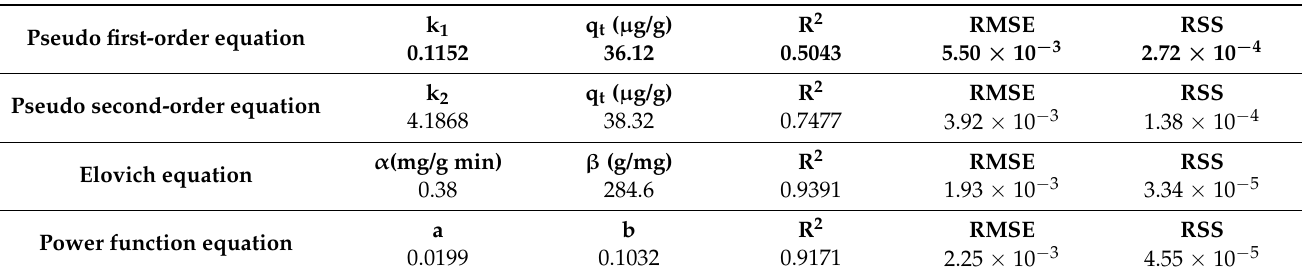
Figure 7. Adsorption kinetics study with several models for As(V) (Conditions: pH = 5, dose 2 g/L (100 mg/50 mL), As concentration 100 µg/L and temperature 25 °C). Table 2. Estimation the kinetic model parameters and correlation coefficients for As(V) adsorption by Magnetic Xerogel Monoliths.